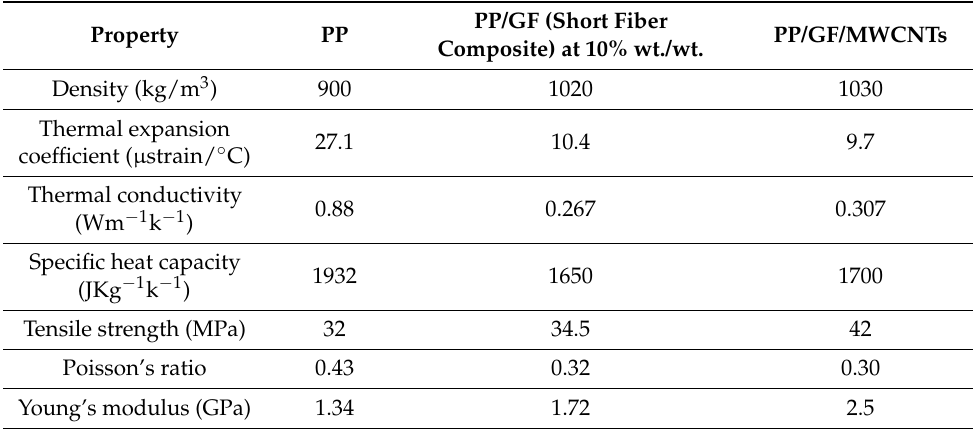
Figure 8. Finite element analysis of mesh: ( a ) blade; ( b ) close view of blade tip. Table 5. Various properties of glass fiber-reinforced thermoplastic